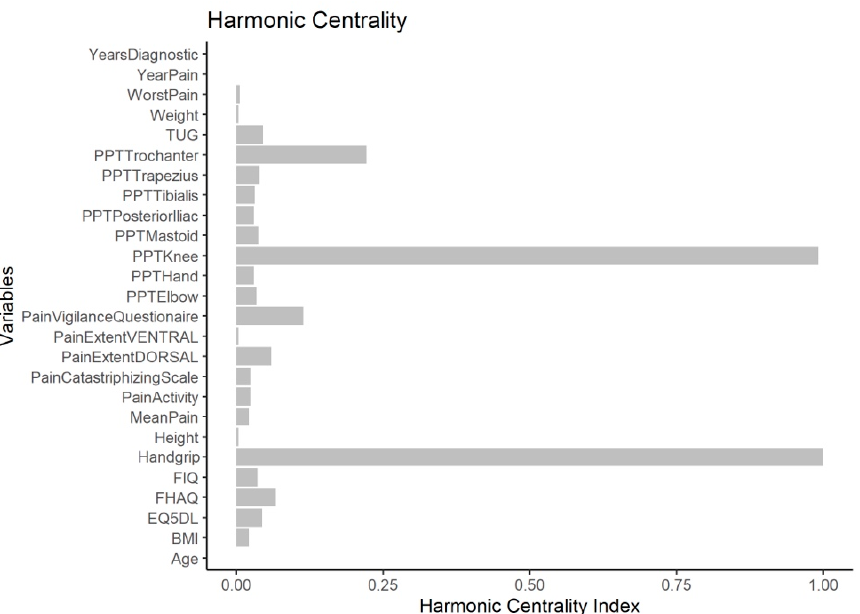
Figure 5. Harmonic centrality measure of each node in the network. A centrality value of 1 indicates maximal importance, and 0 indicates no importance.